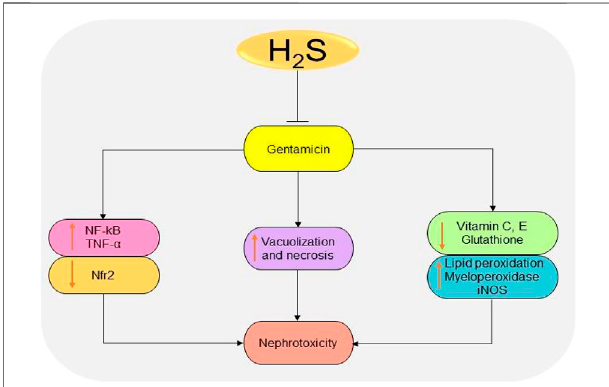
FIGURE7| The diagrammatic illustration of the inhibitory effects of H 2 S donors on gentamicin-induced nephrotoxicity. H 2 S donors prevent gentamicin-inducedoxidativestress,in fl ammation, andnecrosisbyreducing superoxide formation, lipid peroxidation, iNOS, NF- κ B, TNF- α , and malondialdehyde levels. H 2 S, hydrogen sul fi de; iNOS, inducible nitric oxide synthase; NF- κ B, nuclear factor kappa B; TNF- α , tumor necrosis factor- alpha; ROS, reactive oxygen species; Nfr2, nuclear factor erythroid 2-related factor